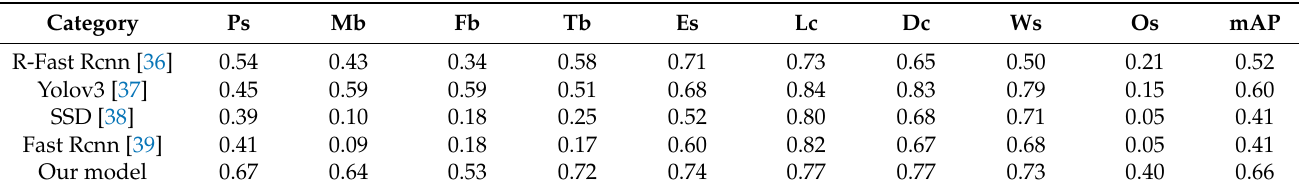
Table 8. AP values of various targets detected in some